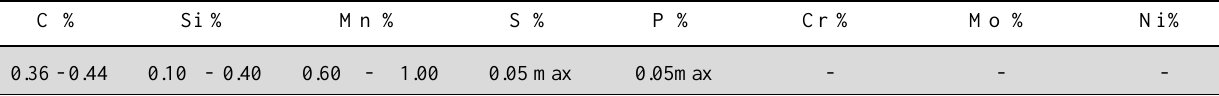
Material Composition of AISI 1040